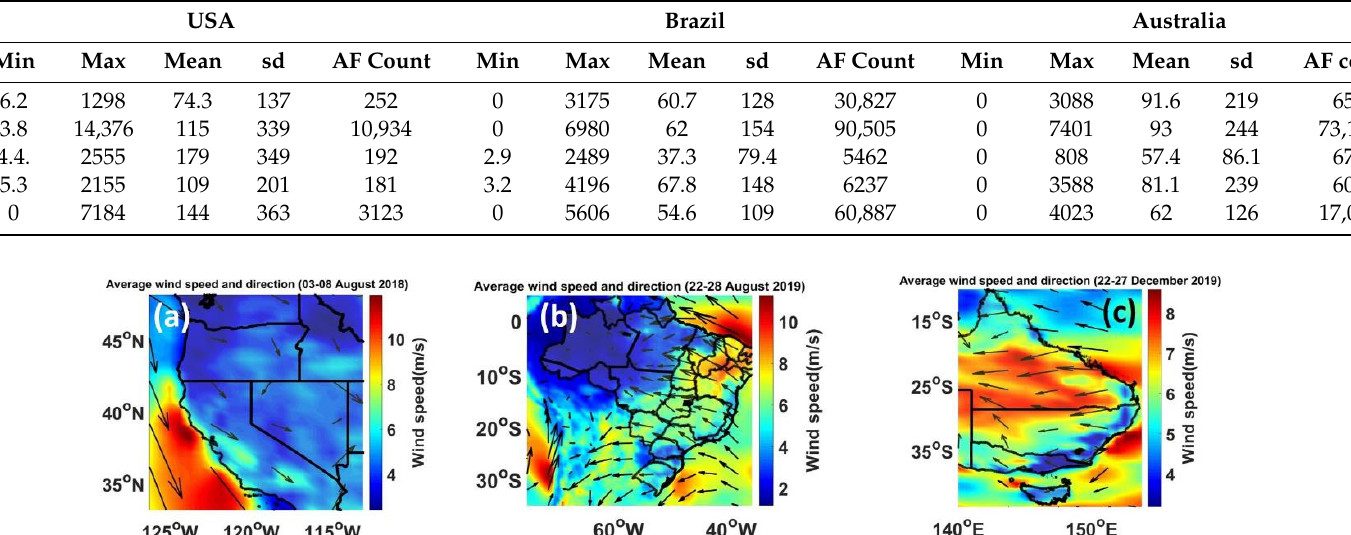
Table A1. Summary statistics indicating Minimum (Min), Maximum (Max), Mean and standard deviation (sd) for FRP and the number of AF (i.e., count) per